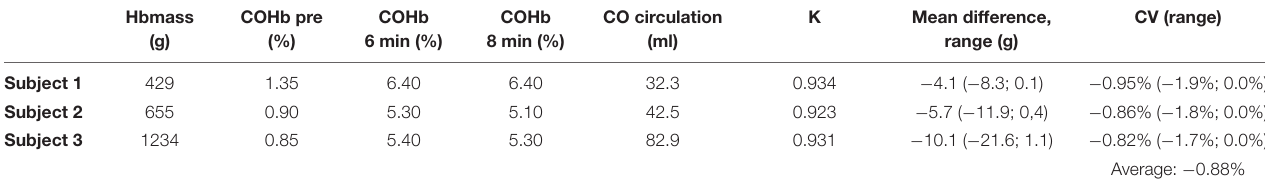
TABLE 2 | Monte Carlo